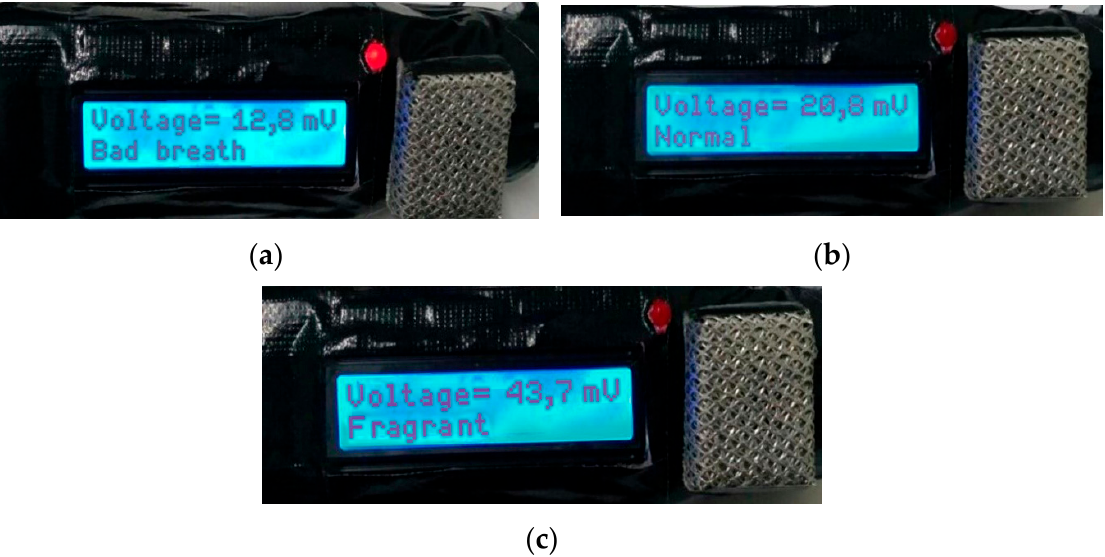
Figure 9. ( a ) The results of the testing at a “Bad breath” oral condition; ( b ) the results of the testing